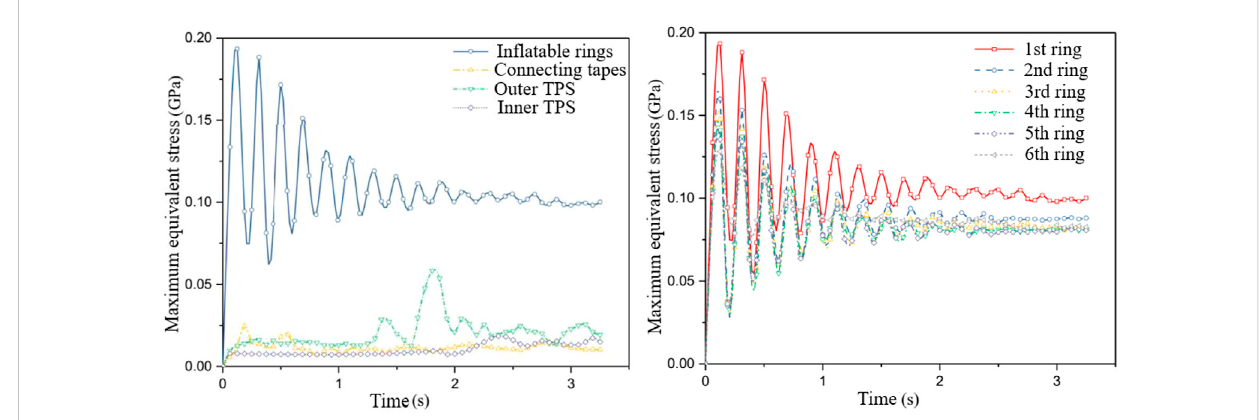
FIGURE 17 Transient displacement and equivalent stress distribution of fl exible structure under internal and external aerodynamic and thermal